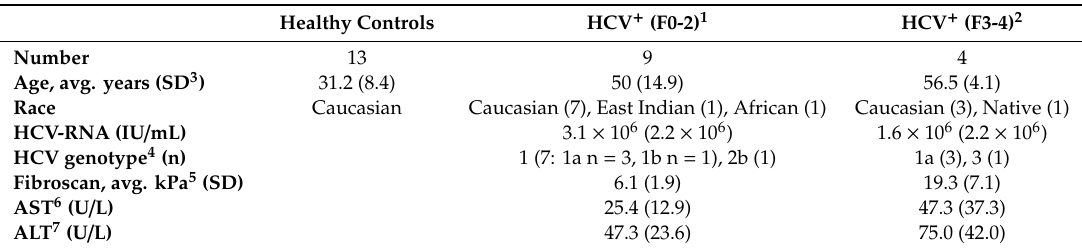
Table 1. Characteristics of healthy controls and hepatitis C virus (HCV)-infected